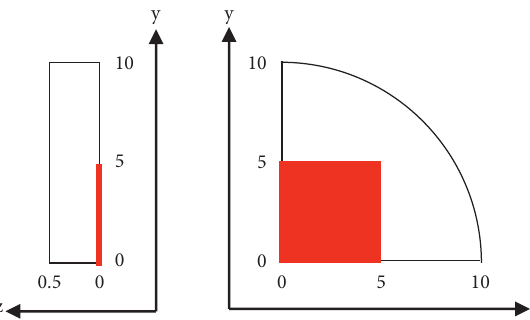
Figure 3: Schematic drawing in side and front views of a quarter of the simulated target disc with the plane of the disc oriented in x - and y - directions and the thickness in z -direction. All units are in mm. Note that the z -direction is not drawn to scale for better view. The beam spot is marked in red. The velocity is measured in the centre of the rear side ( x � y ≈ 0, z � 0.5).